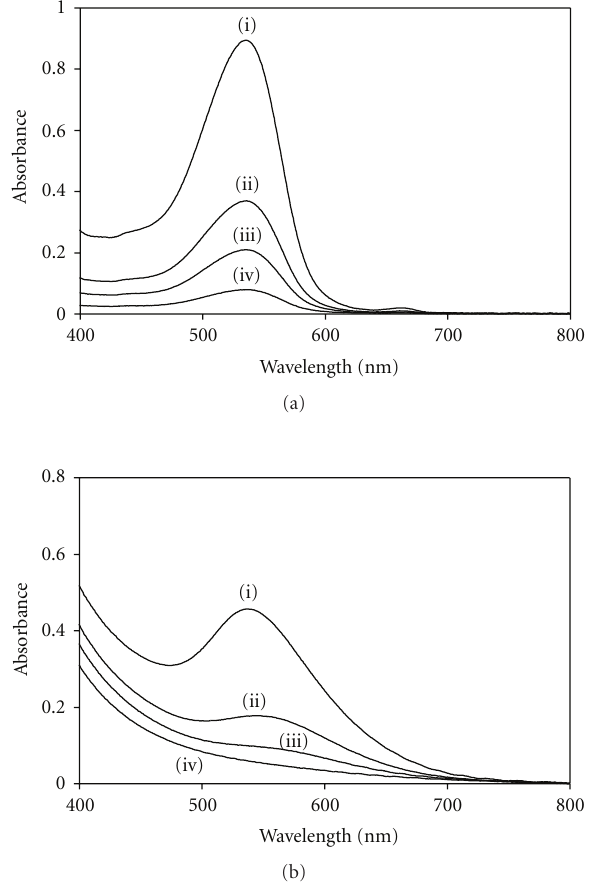
Figure 4: The absorption spectra of anthocyanin (a) in ethanol solution and (b) on TiO 2 extracted from black rice at pH (i) 1, (ii) 2, (iii) 3, and (iv) 4.